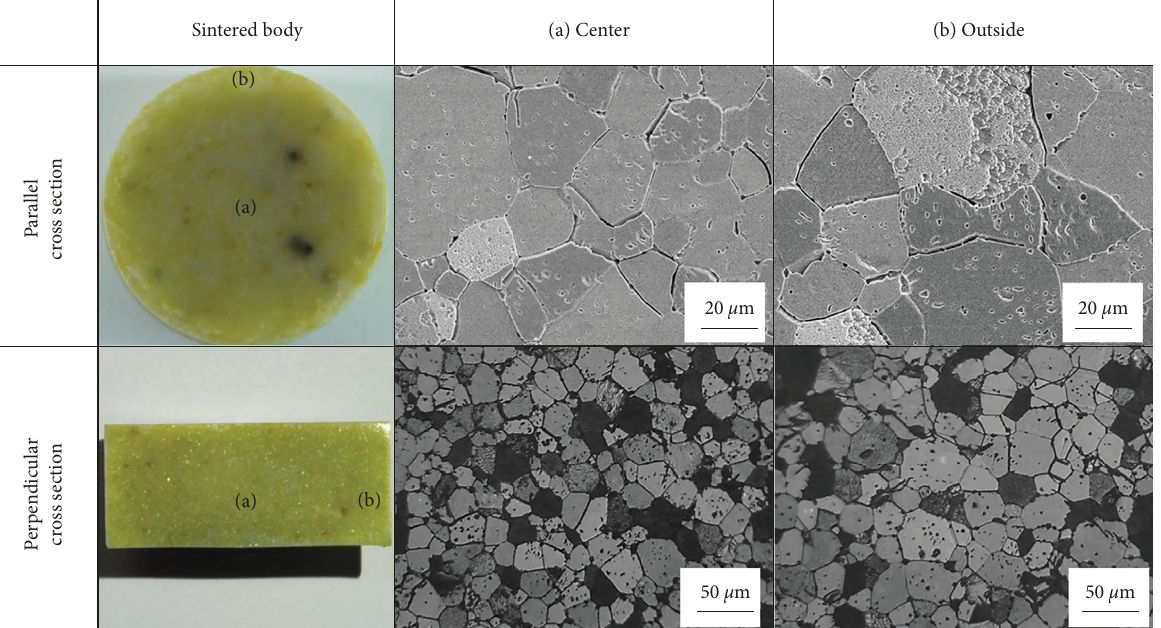
Figure 5: Perpendicular and parallel cross-sectional microstructures of the ZnO ceramics compacted by MPC and sintered at 1300 ° C for 2h recorded from (a) central region and (b) outer